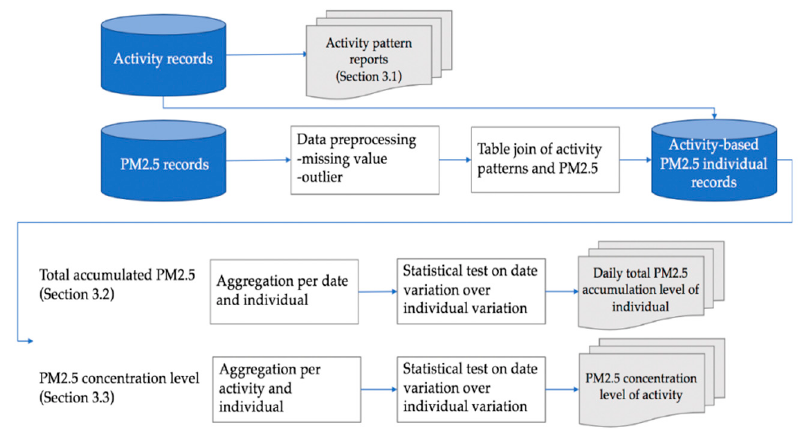
Figure 2. Analysis framework for real-time PM2.5 concentration level by activity.